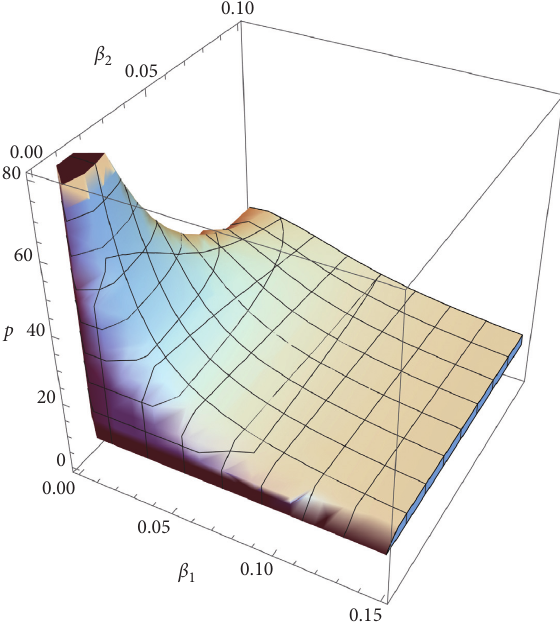
Figure 14: The 3D stable region with change of β